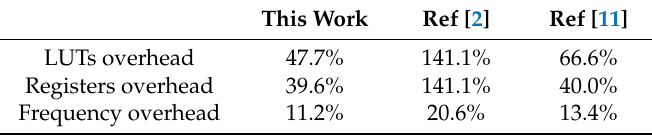
Table 4. Comparisons with other DPA-resistant SIMON circuits. This